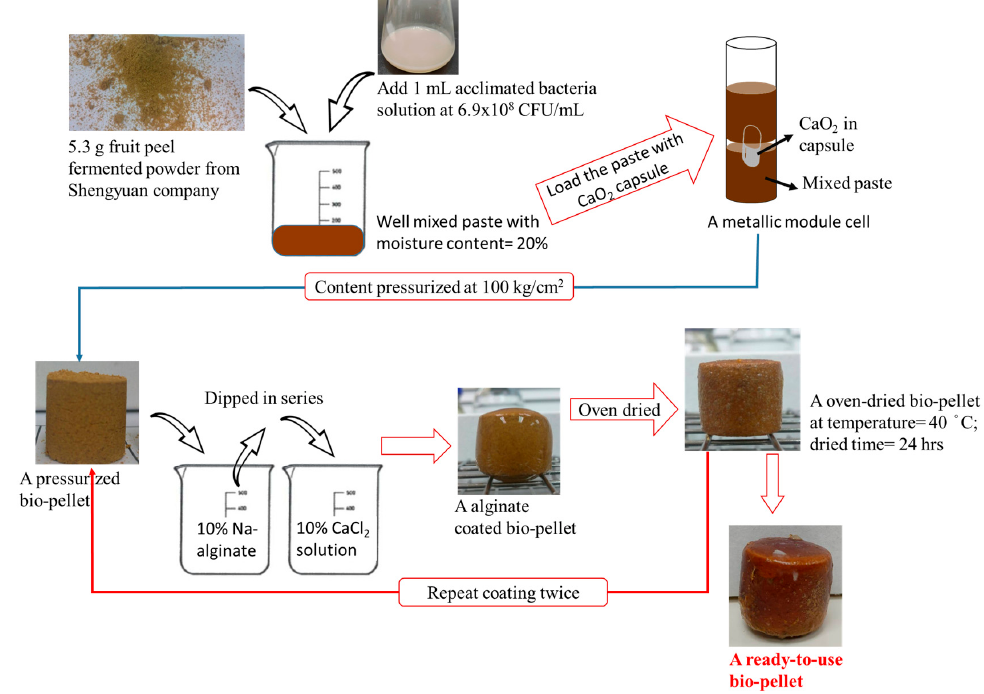
Figure 3. The biopellet manufacturing process.